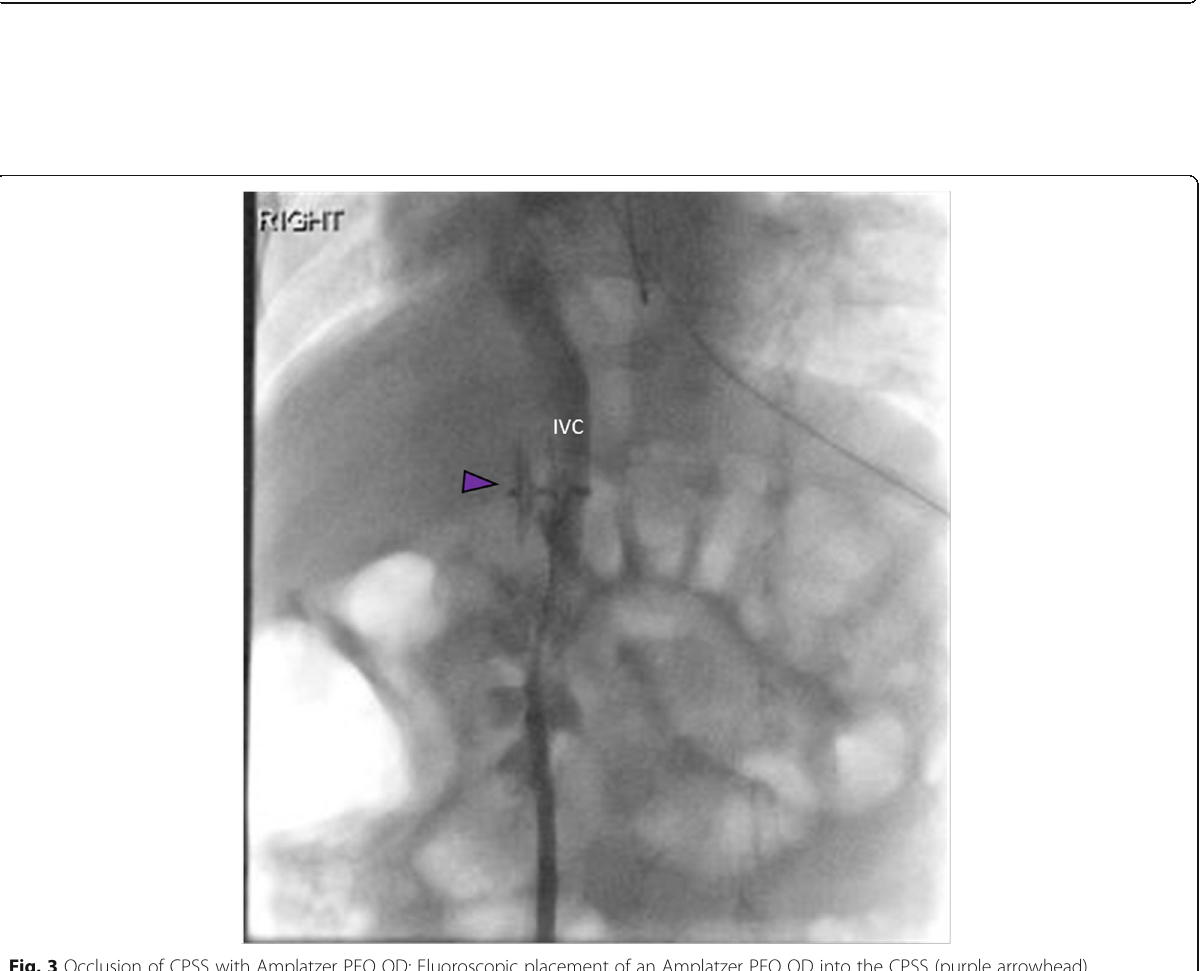
Fig. 2 Fluoroscopic evidence of CPSS. Contrast injection upon cannulation of fistulous connection between IVC and right PV branch (blue arrowhead) with a 7F sheath. Contrast is seen flowing into the MPV (labeled) and superior portion of the IVC